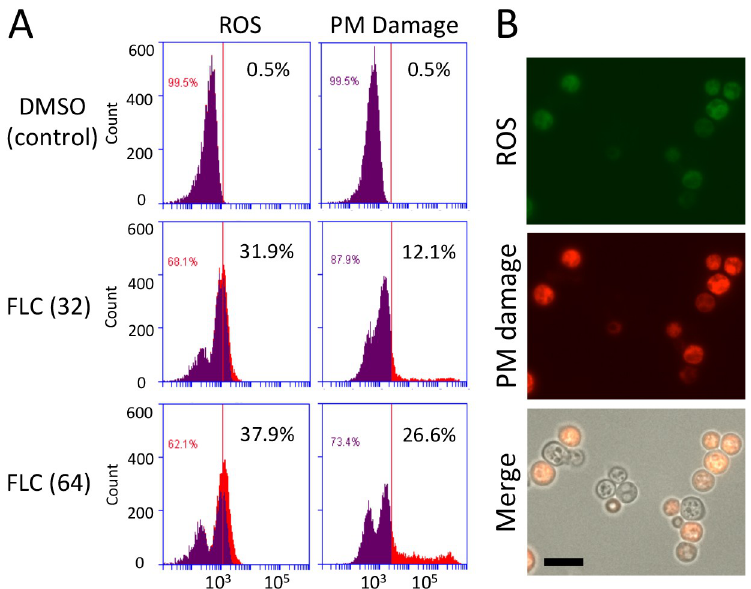
Fig 1. The effect of FLC treatment on ROS and plasma membrane integrity in C . neoformans . Cells (strain H99) were incubated in YPD medium supplemented with 0.1% (v/v) DMSO, 32 μ g/ml (A) or 64 μ g/ml (A, B) at 24˚C for 8 (A) or 24 (B) hours. ROS (fluorescence of the H 2 DCFDA) and plasma membrane (PM) damage (fluorescence of the propidium iodide (PI)) was detected by either flow cytometry (A) or under fluorescence microscope (B). Vertical lines in the graphs indicate arbitrary boundary between background and elevated levels of the H 2 DCFDA and PI fluorescence whereas percentages indicate fraction of cells with elevated fluorescence. In the ROS graphs, purple area indicates the ROS content in the cell subpopulation that shows background PI fluorescence. Orange indicates ROS content in the cell subpopulation with elevated PI stain. Bar in B corresponds to 10 microns. https://doi.org/10.1371/journal.pone.0208471.g001 was upregulated at 1 h incubation at FLC 32 μ g/ml (log fold change = 0.75 ± 0.41, p = 0.0341) 2 (Fig 2). CMT1 and CMT2 , as predicted, exhibited elevated transcripts in the presence of CuSO ( CMT1 log fold change = 1.72 ± 0.41, p = 0.002; log fold change = 2.53 ± 0.41, 4 2 2 p = 0.0004 for 32 or 64 μ g/ml FLC, respectively; CMT2 log 2 fold change = 3.19 ± 0.61, p = 0.001; log 2 fold change = 2.59 ± 0.33, p = 0.0002 for 32 or 64 μ g/ml FLC, respectively) (Figure C in S1 File). However, the effect of FLC on CMT1 and CMT2 transcription was